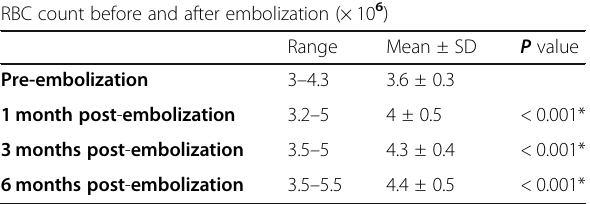
Table 4 Laboratory response based on RBC count